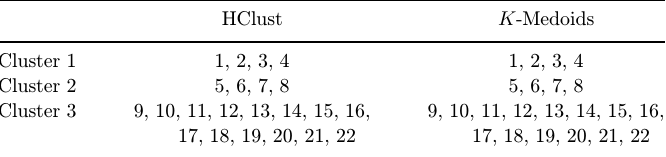
Table 3. Comparative table using supersets as descriptors of textual